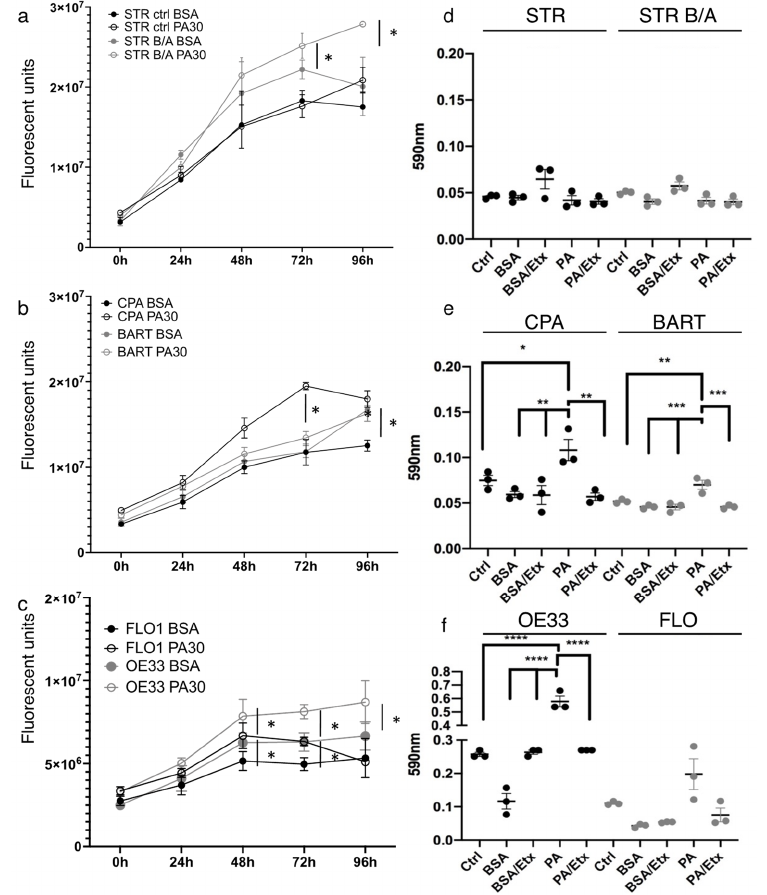
Figure 4. Palmitic acid promotes proliferation and increases the capacity for colony formation in EAC. Cell proliferation was determined using the CellTiter assay showing that stimulation with 30 µM palmitic assay increases growth significantly compared to BSA control in bile/acid-tolerant STR but not normal esophageal STR ( a ). ( b ) The proliferation of BE cell lines, CPA and BAR-T, is enhanced with 30 µM palmitic acid, so is cell growth in esophageal adenocarcinoma cell lines compared to BSA control ( c ). Crystal violet stain was quantified for colony formation of STR and STR B/A ( d ), BE ( e ) and EAC ( f ) cell lines. STR and STR B/A did not form measurable colonies, but colony formation is significantly increased in CPA, BAR-T and OE33 cells upon stimulation with 30 µM PA. There is a trend for augmented colony formation in the FLO cells, but it is not significant. * p < 0.05 ; ** p < 0.0 ;*** p < 0.001;**** p < 0.0001 . 2.4. IL1 β and IL8 Expression Is Induced by PA Stimulation in the Early Stages of BE Pathology Obesity is associated with low-grade inflammation and elevated levels of circulating saturated fatty acids, which trigger inflammatory responses through an increase in pro- inflammatory cytokines [44]. Relevant to the BE pathology are IL1 β and IL8 which have been shown to be increased during the stepwise progression from normal through Bar- rett’s epithelium to adenocarcinoma [45]. We therefore assessed the expression of hIL1B and IL8 in the context of CPT1A expression upon PA stimulation and inhibition with etomoxir. Based on qRT-PCR data, hIL1B expression was significantly enhanced in STR